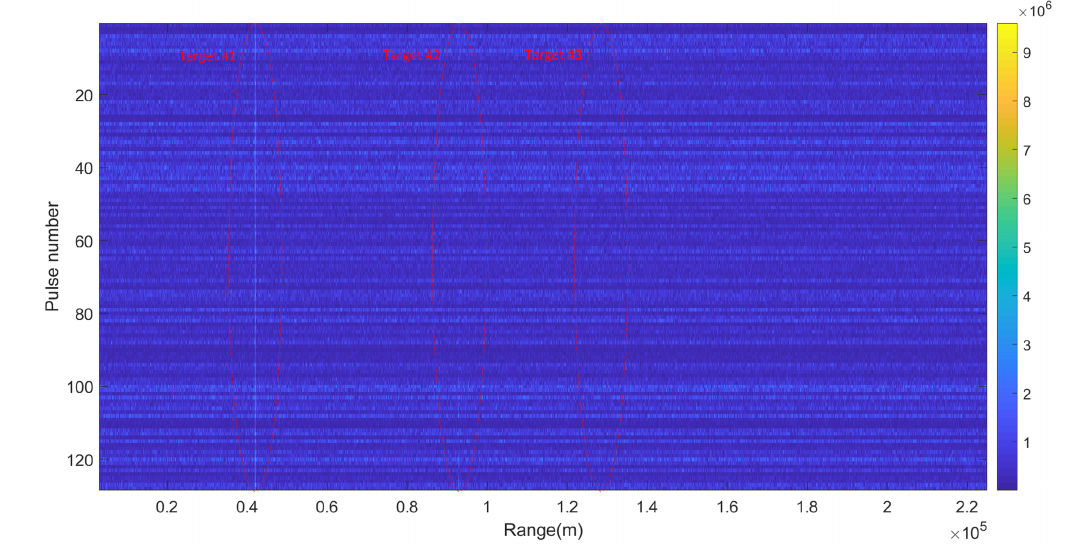
Figure 16. Time-range map after pulse compression and realignment.